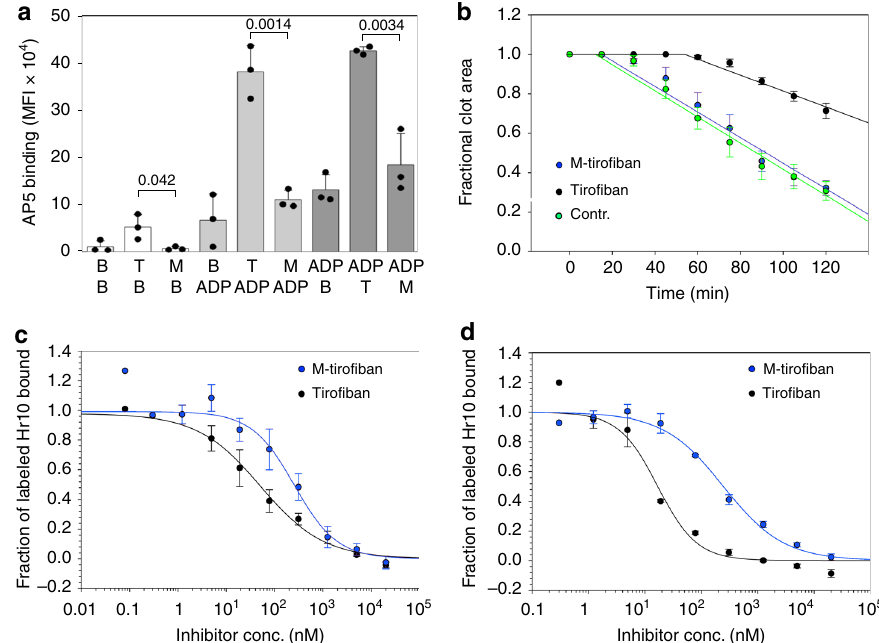
Fig. 8 M-tiro fi ban is a pure α IIb β 3 antagonist. a Histograms (mean + s.d., n = 3 independent experiments) showing binding of mAb AP5 to human platelets in presence of buffer (B), tiro fi ban (T; 150 nM), and M-tiro fi ban (M; 1.5 μ M; white histograms), and before (gray histograms) or after (dark gray histograms) addition of ADP (5 μ M). Numbers represent p values (Student ’ s t -test, two-tailed). No signi fi cant differences were found between buffer and M-tiro fi ban before ( p = 0.273) or after ( p = 0.81; both Student ’ s t -test, two-tailed) ADP addition. b Kinetics of clot retraction in absence or presence of tiro fi ban, or M-tiro fi ban (mean + / − s.e., fi ve experiments with three donors). Kinetics of clot retraction was not different between buffer control (contr.) and M-tiro fi ban ( p = 0.61, F -test, two-tailed). c , d Dose – response curves (mean + / − s.e.) comparing displacement of Alexa488-labeled Hr10 binding to inactive ( c , n = 5) or mAb PT-25-activated α IIb β 3- K562 ( d , n = 3) by increasing concentrations of tiro fi ban or M-tiro fi ban in presence of physiologic concentrations of Mg 2 + and Ca 2 + (1 mM each). The respective IC 50 s were 51.3 + / − 19.2 nM and 257.2 + / − 88.0 nM for inactive α IIb β 3, and 16.9 + / − 2.4 nM and 247.1 + / − 29.3 nM for active α IIb β 3. The lower af fi nities of both compounds are explained by the requirement for more inhibitor to displace high af fi nity binding of Hr10 (compared to binding of FB in Fig. 7c) to α IIb β